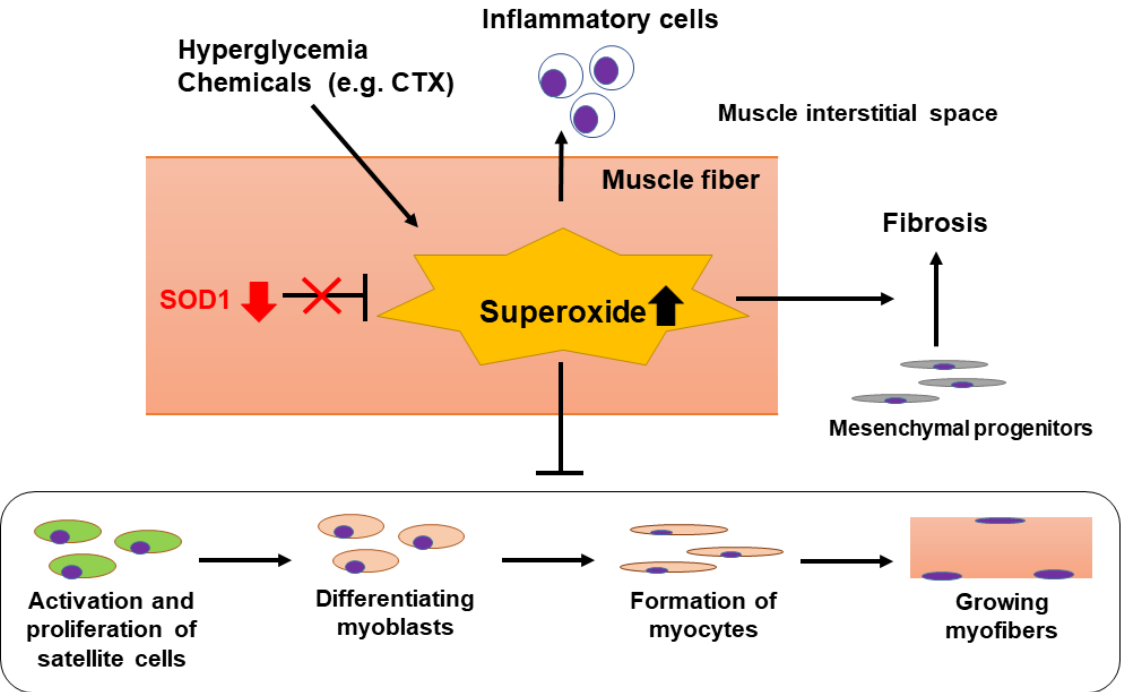
Figure 5. Proposed mechanism of delayed skeletal muscle regeneration in DN-prone KK/Ta-Akita mice. During exposure to hyperglycemia or chemicals such as CTX, excessive superoxide anions are produced in muscle fibers. Oxidative stress induced by superoxide overproduction would increase inflammatory cell infiltration into the muscle interstitial spaces, accelerate muscle interstitial fibrosis, and delay differentiation of myoblasts and regeneration of myofibers via suppressing activation and proliferation of satellite cells. When SOD1 removes superoxide anions effectively, these inflammatory and fibrotic changes would be attenuated, leading to promoting regeneration of injured muscles. Hence, SOD1 down-regulation observed in TA muscles of DN-prone KK/Ta-Akita mice following CTX injection may be involved in their delayed skeletal muscle regeneration.